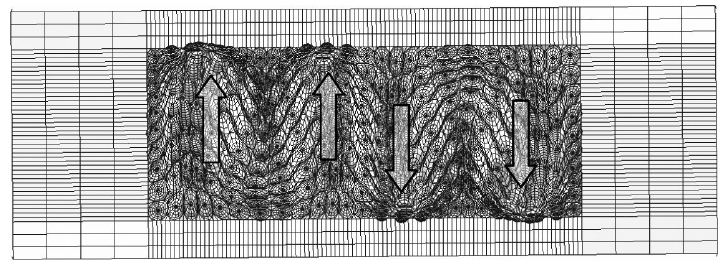
Fig. 51. EIDL 11th mode – 993 Hz – in plane quadruple opposite vertical translation.